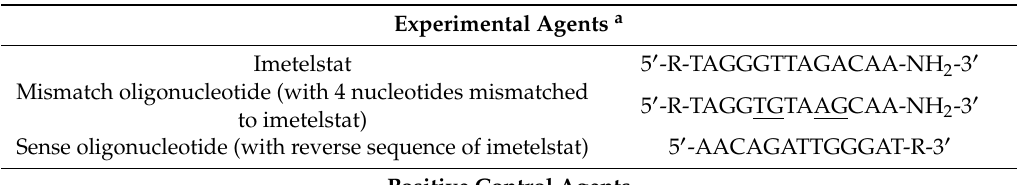
Table 1. Ligands for the Toll-like receptor (TLR) activation